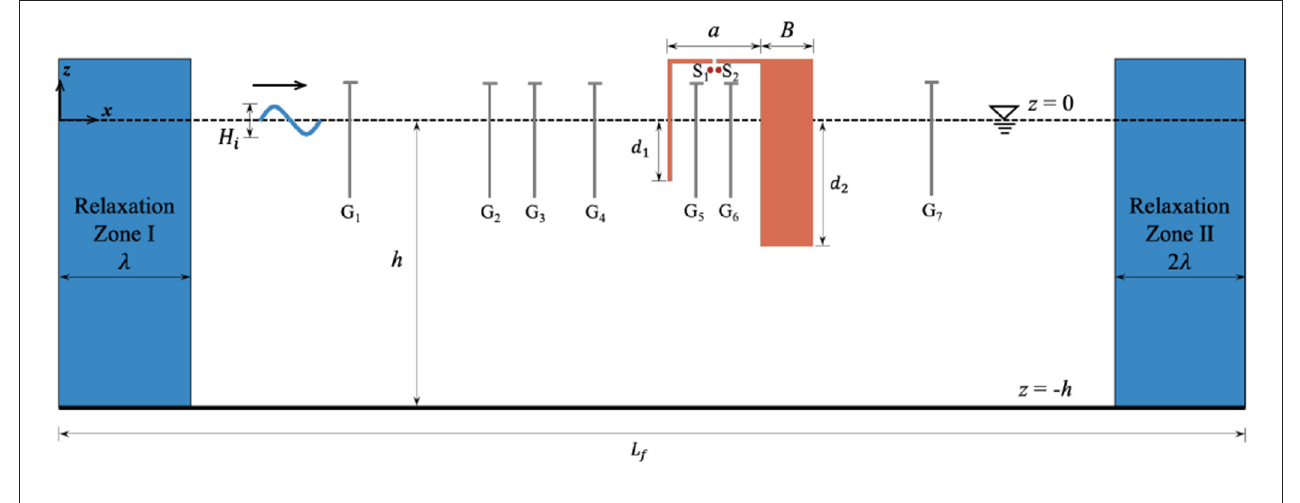
FIGURE 3 | Sketch of numerical wave